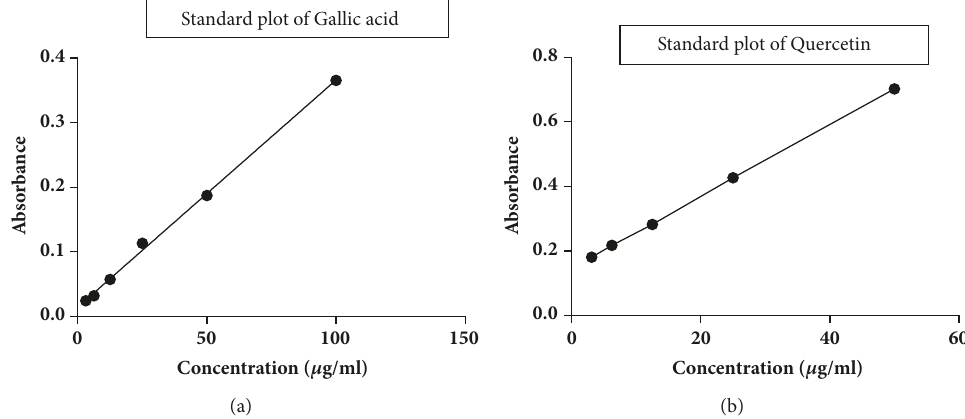
Figure 1: (a) Standard plot of gallic acid. (b) Standard plot of quercetin.